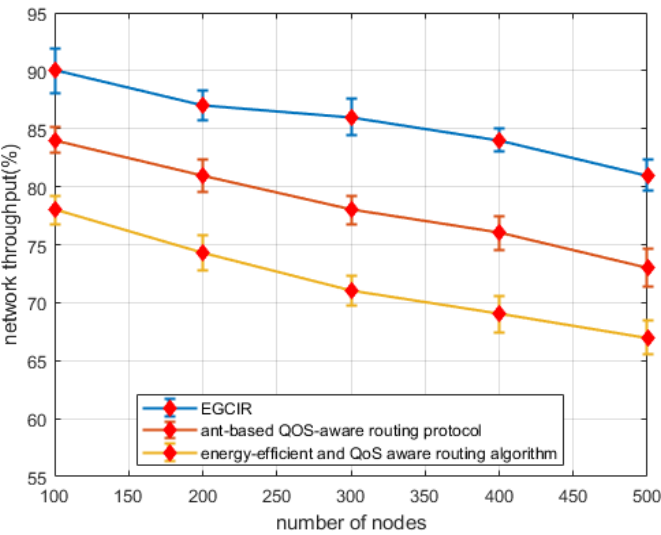
Figure 2. Impact of the nodes and network throughput